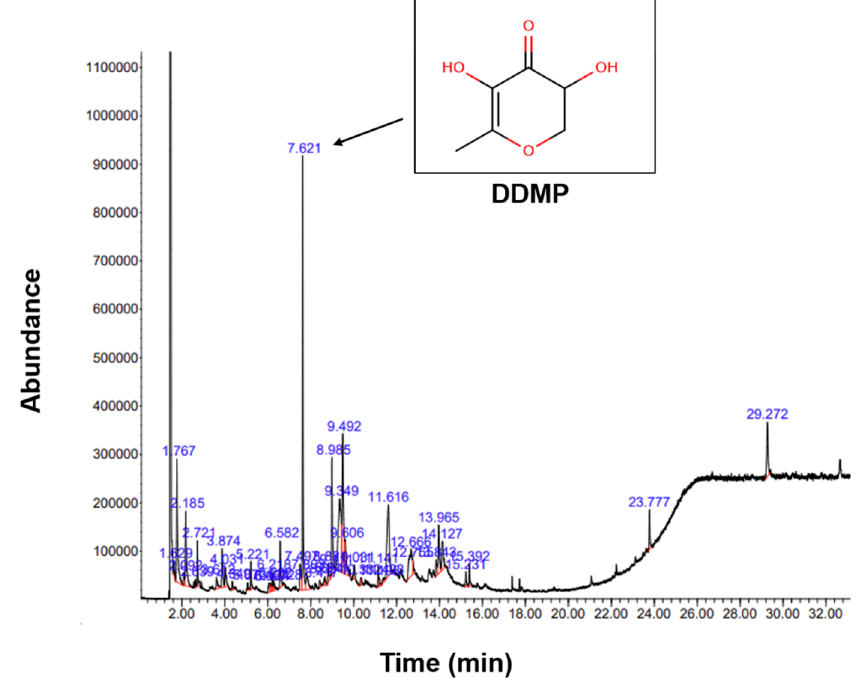
Figure 1. The GC–MS chromatogram of Bv-EE. Table 1. Phytochemical analysis of Bv-EE by